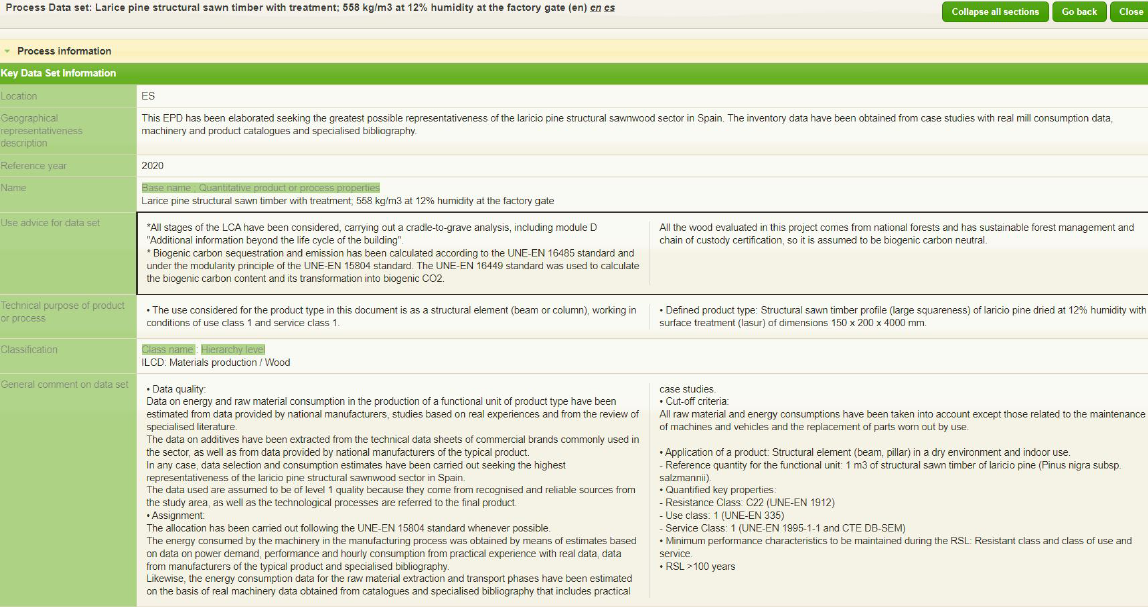
Figure 3. Screenshot of OpenDAP in ILCD+EPD